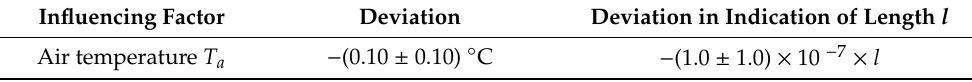
Table 7. Example of a calibration result of an air temperature sensor and the e ff ect on a measured length. Influencing Factor